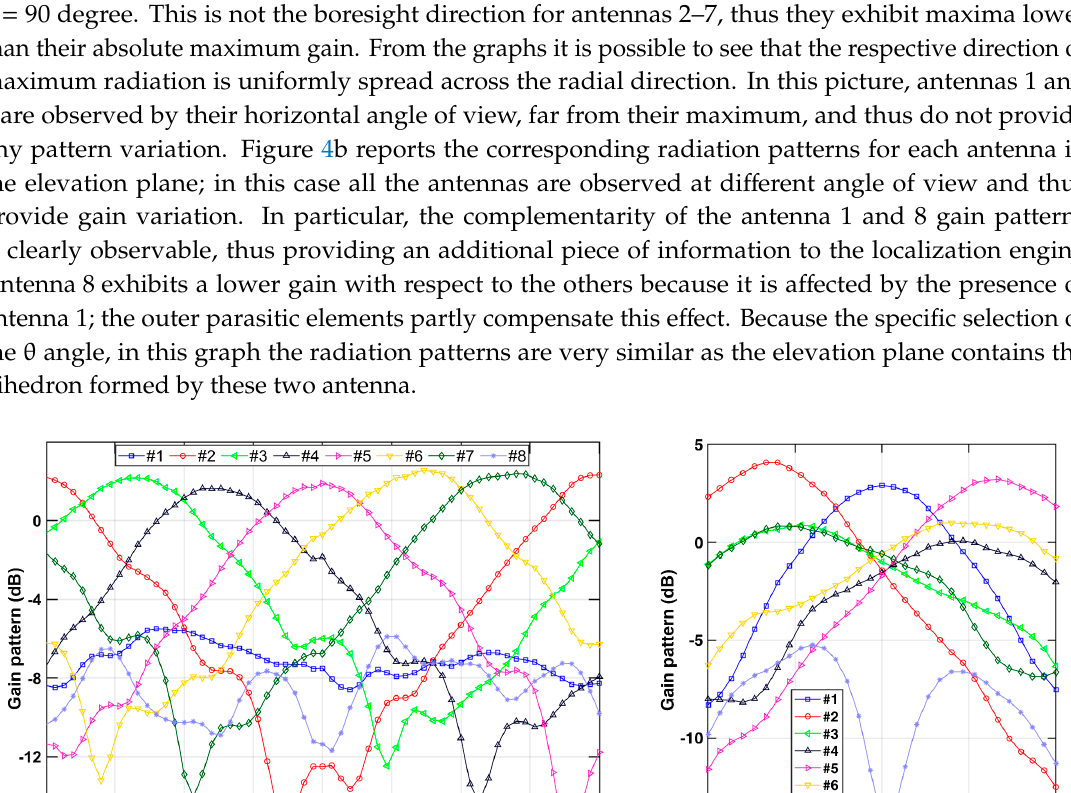
Figure 4. Switched Beam Array: ( a ) measured pattern in azimuthal plan; ( b ) pattern at ϕ = 70° (side pointing perpendicular direction).